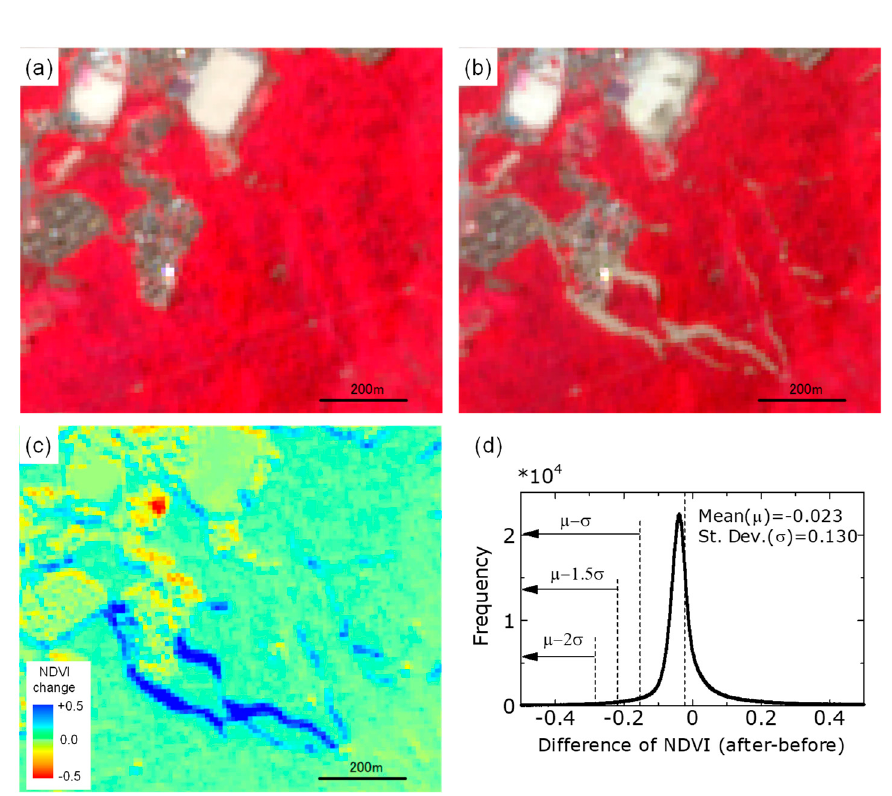
Figure 7. ( a ) Pre- event Sentinel-2 image in Kumano town. ( b ) Post-event Sentinel-2 image. ( c ) Distribution of NDVI change (after-before) with debris flow areas. ( d ) Histogram for difference of NDVI and thresholds for change detection.